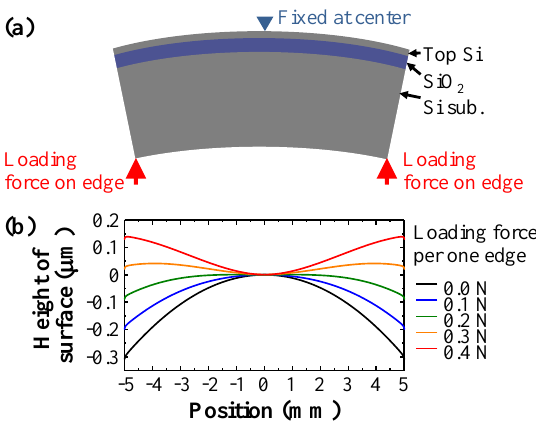
Figure 8. Warpage of SOI wafers: ( a ) Experimental measurement of the warpage of the surface of SOI wafers; ( b ) Analytical warpage of the surface of SOI wafers by 2D finite-element method (FEM calculations.